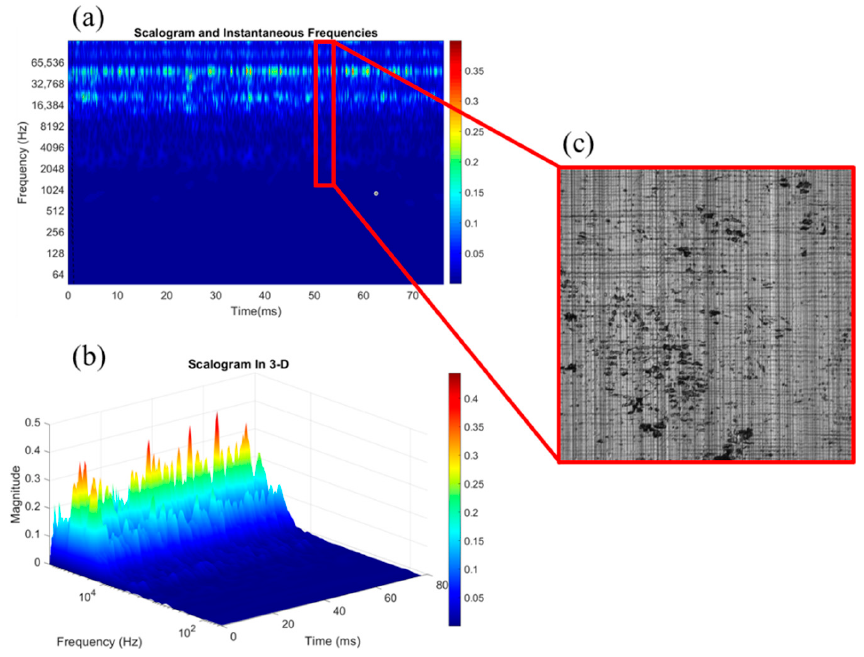
Figure 10. ( a ) 2D scalogram, ( b ) 3D scalogram, and ( c ) surface image for 21 um depth of cut at 60 m/min.